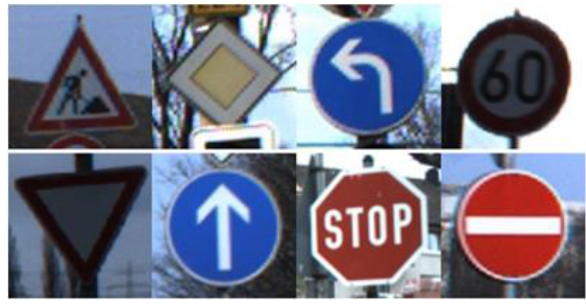
Figure 8. GTSRB image sample used in the experiment .